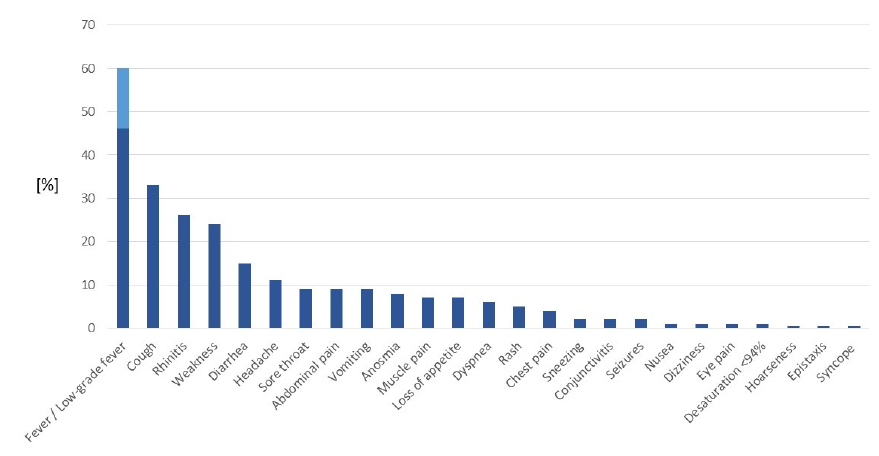
Figure 2. Clinical symptoms of COVID-19 in 1283 children. Data are presented as the frequency of the symptoms (%).